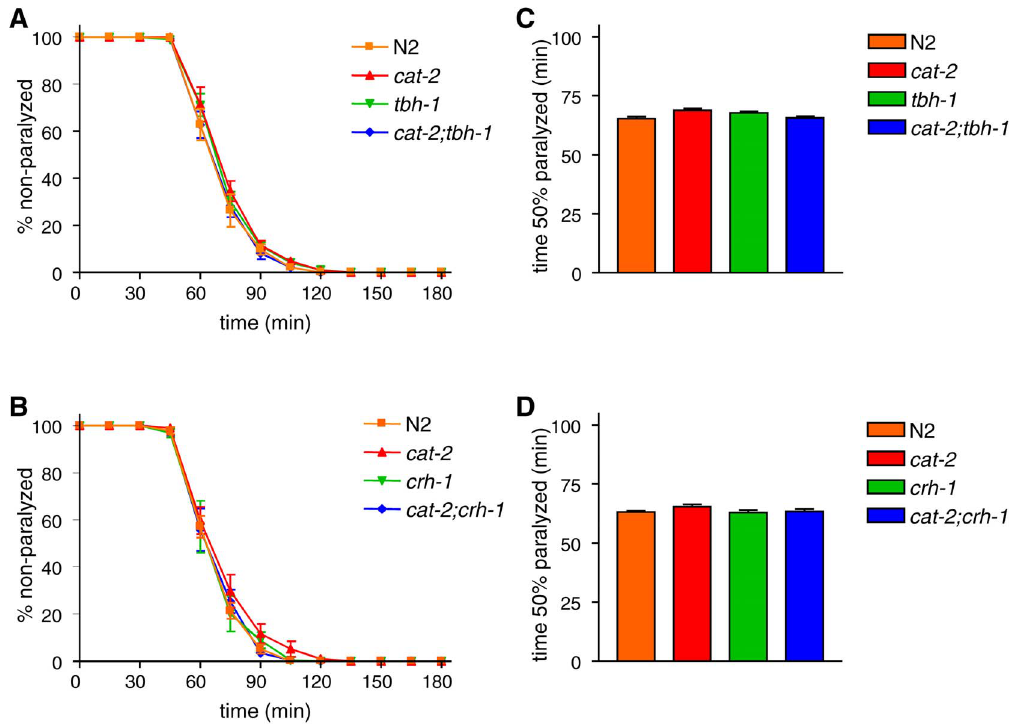
Figure 3. Levamisole sensitivity was unchanged in the cat-2 , tbh-1 , and crh-1 mutants. (A and B) Animals were examined for paralysis on NGM plates containing 0.2 mM levamisole. (C and D) The time required for 50% of the animals to become paralyzed was determined using Prism. A one-way ANOVA revealed that cat-2 , tbh-1 , or crh-1 mutation does not significantly alter levamisole sensitivity (P . 0.05). Error bars indicate the SEM.